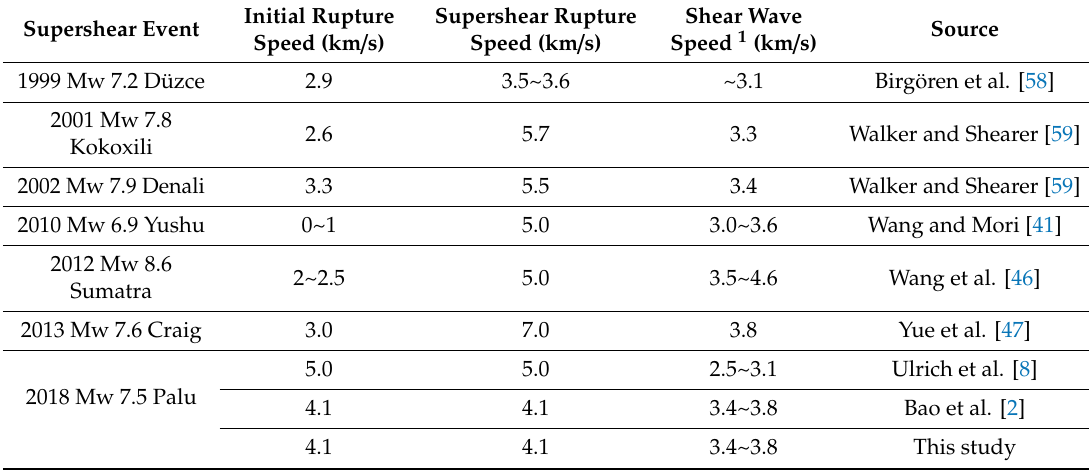
Table 2. Comparisons with rupture speed of supershear